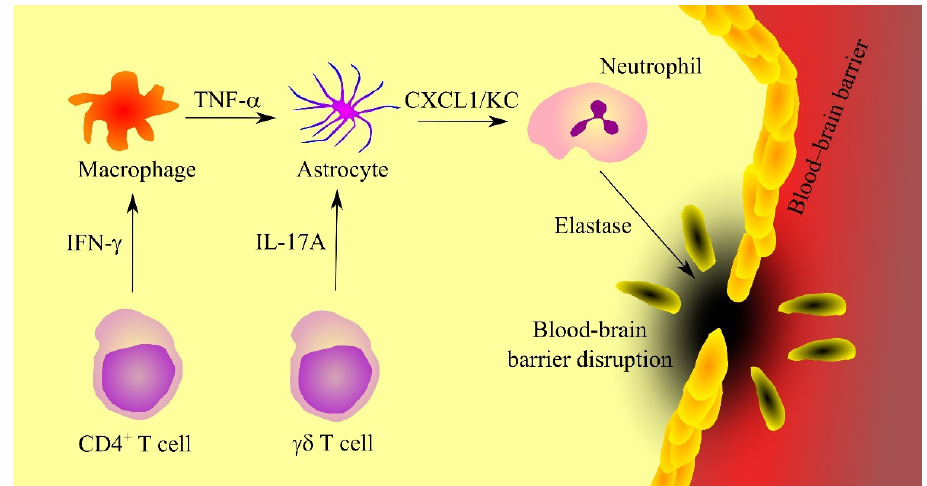
Figure 4. The significance of CXC motif chemokine ligand 1 (CXCL1)/keratinocyte-derived chemokine (KC) in ischemic stroke. Ischaemic stroke is associated with neuroinflammation caused by γδ T cells and CD4 + T cells that respectively secrete interleukin-17A (IL-17A) and interferon- γ (INF- γ ). INF- γ increases tumor necrosis factor α (TNF- α ) production in macrophages. TNF- α and IL-17A increase the secretion of CXCL1/KC in astrocytes. This chemokine causes recruitment of